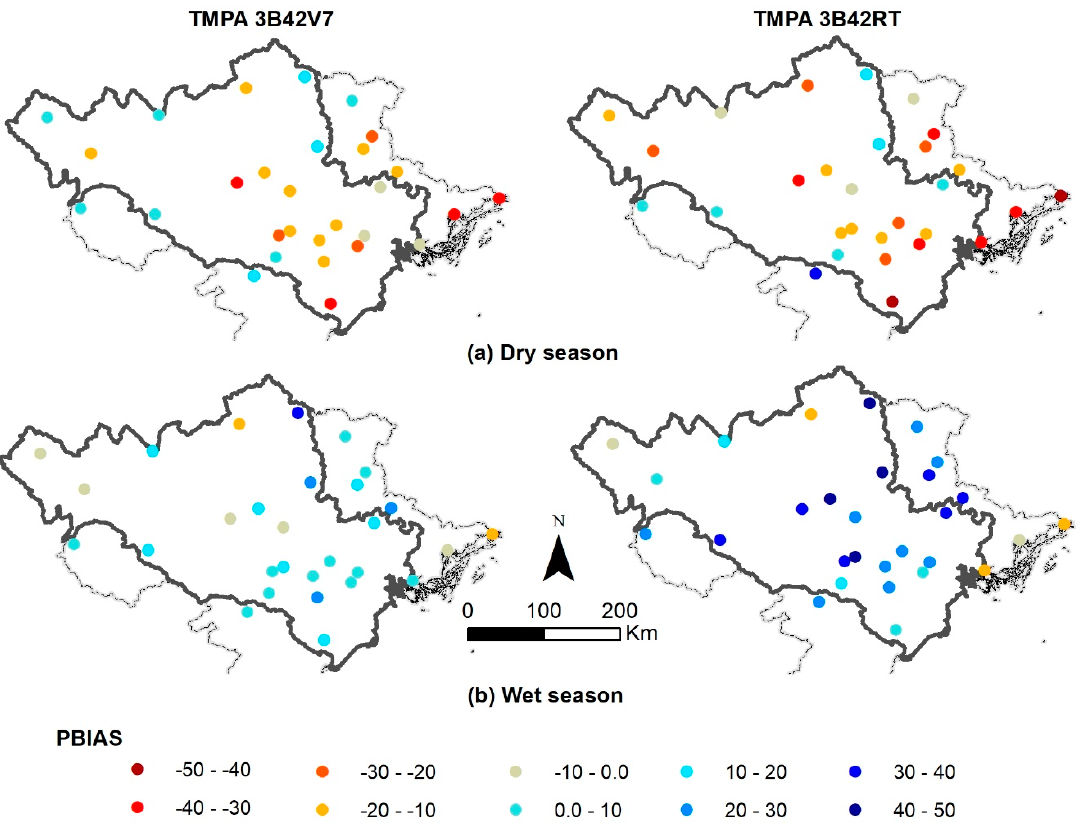
Figure 4. PBIAS score’s spatial performance of TMPA rainfall data against observation data during ( a ) the dry and ( b ) the wet season from March 2000 to December 2016 over the Red–Thai Binh River Basin. The grey line is the Red–Thai Binh River Basin boundary within Vietnam territory.